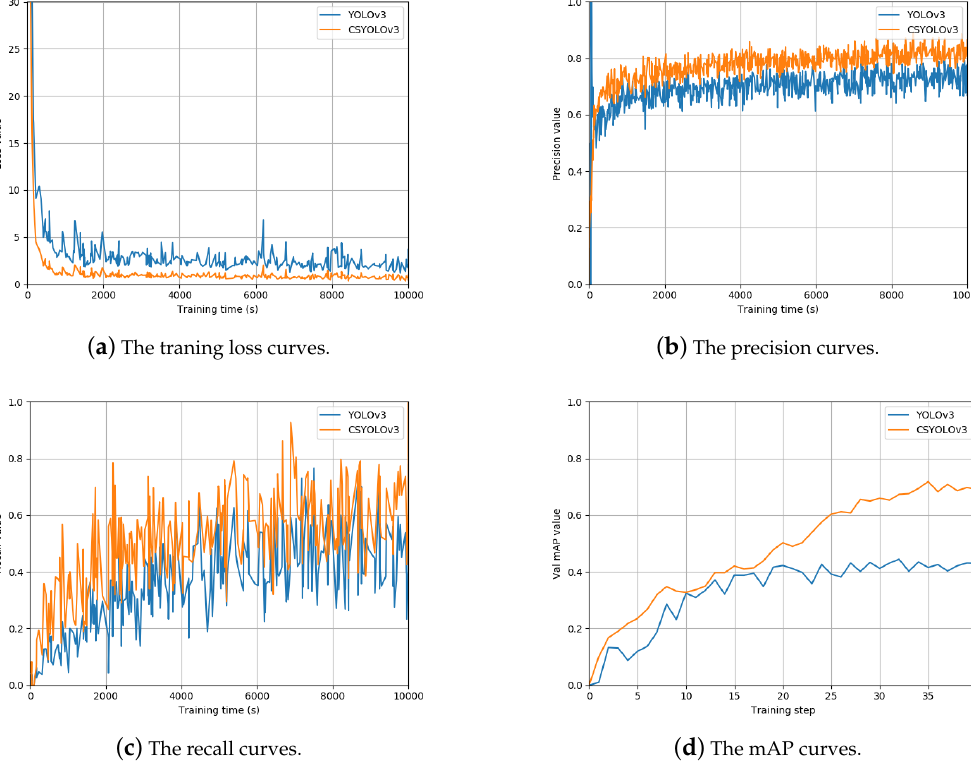
Figure 6. The experimental data curves of YOLOv3 and